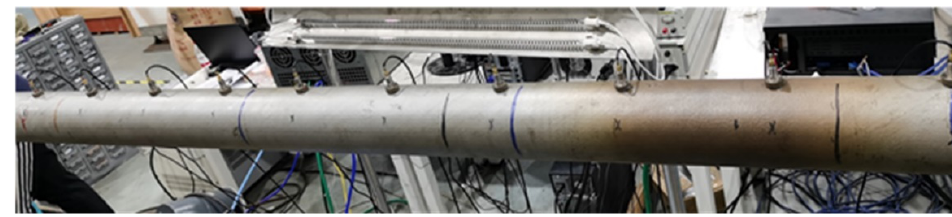
Figure 12. Vibration response of rigid pipeline.